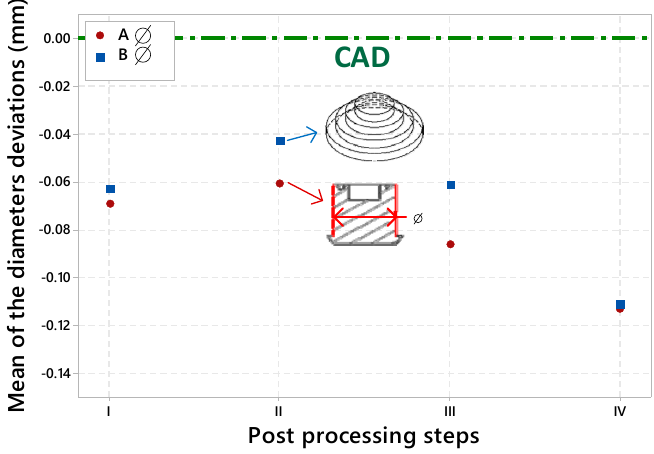
Figure 15. The mean of the mean diameter deviation of each shape at each post-processing step .